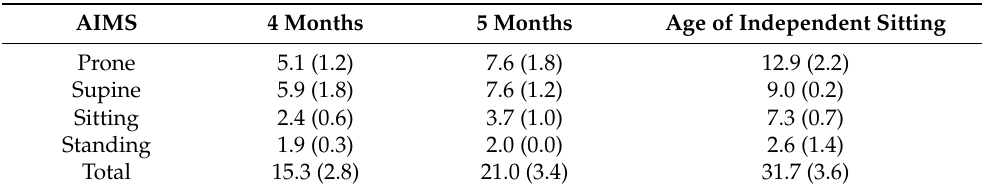
Table 3. Mean (SD) total and subscale of AIMS scores at 4- and 5-month corrected ages, and at the corrected age of independent sitting ( n = 33).